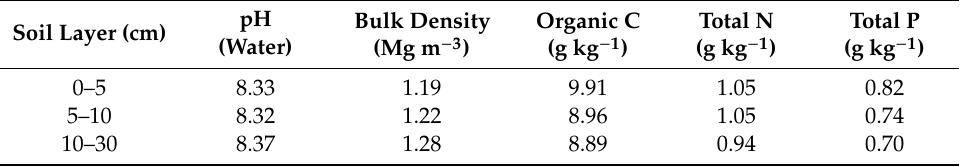
Table 1. Soil chemical and physical properties prior to sowing in